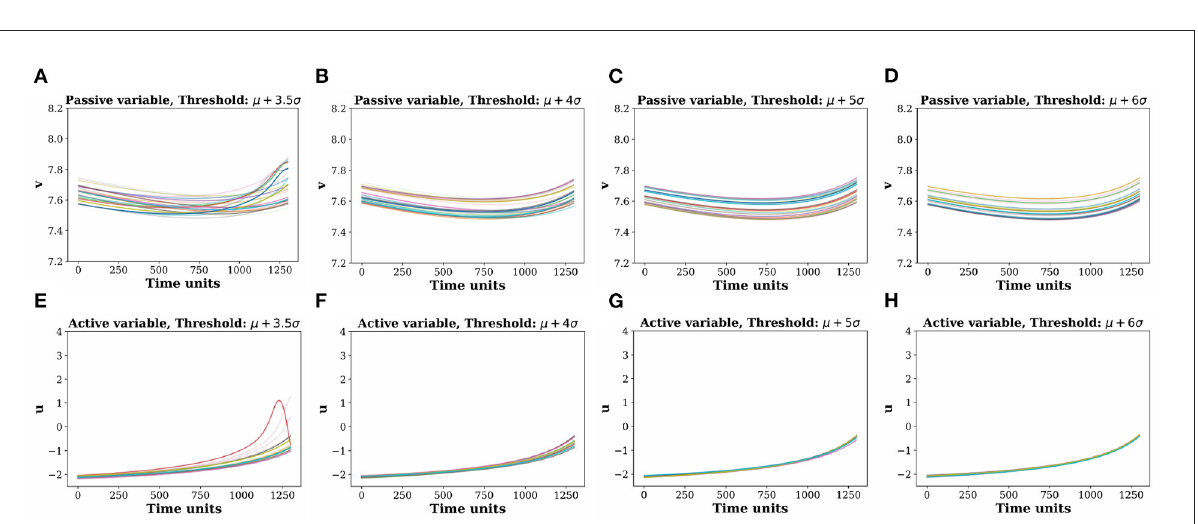
FIGURE4 Comparative picture of coherence in the input time signals ( p ) extracted before an extreme events. (A–D) Input signal of passive variable v for threshold values ( d = 3.5,4,5,6). (E–H) are the corresponding active variable u for threshold values ( d = 3.5,4,5,6). Coherence between the input time signals increases with the threshold height determined by higher d -values. Different color signifies different